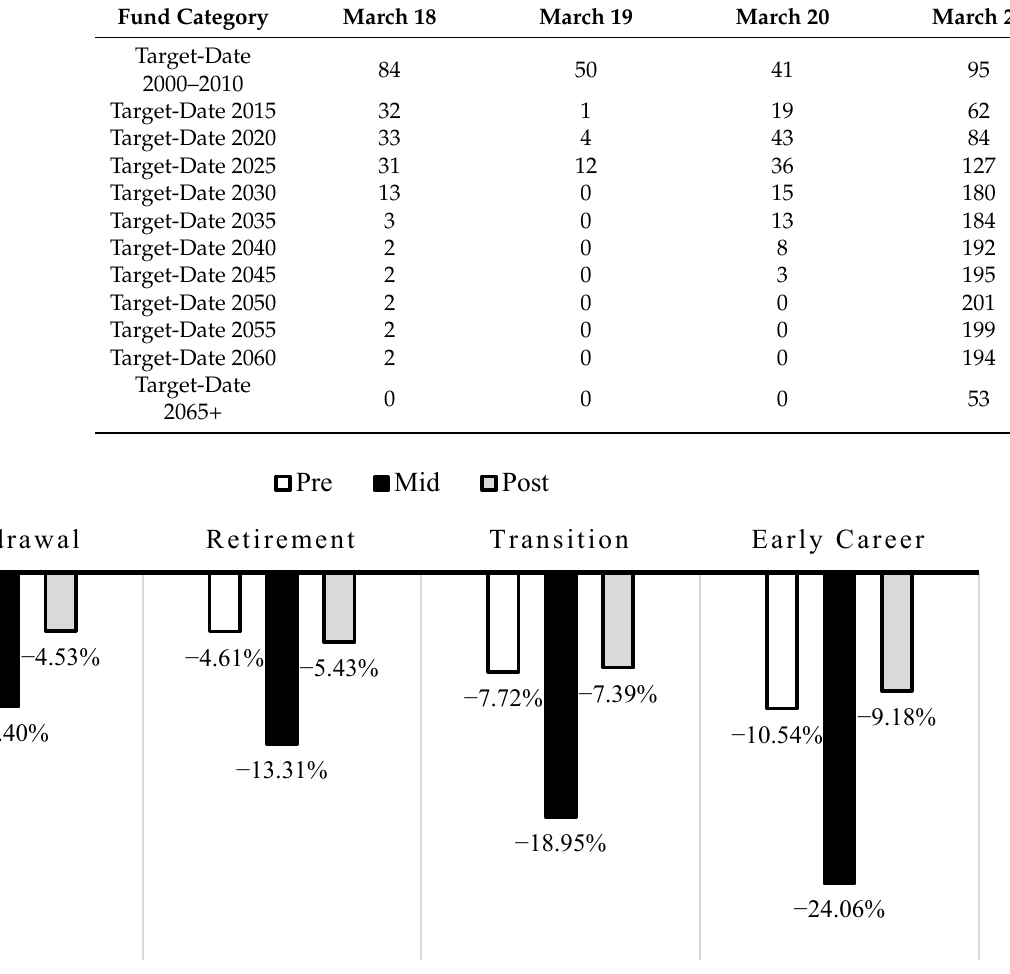
Figure 6. Average Maximum Drawdown by Portfolios over Sub-Sample Periods. Table 4. Maximum Drawdown Statistics by Portfolio Classification (Three Sub-Sample Periods).